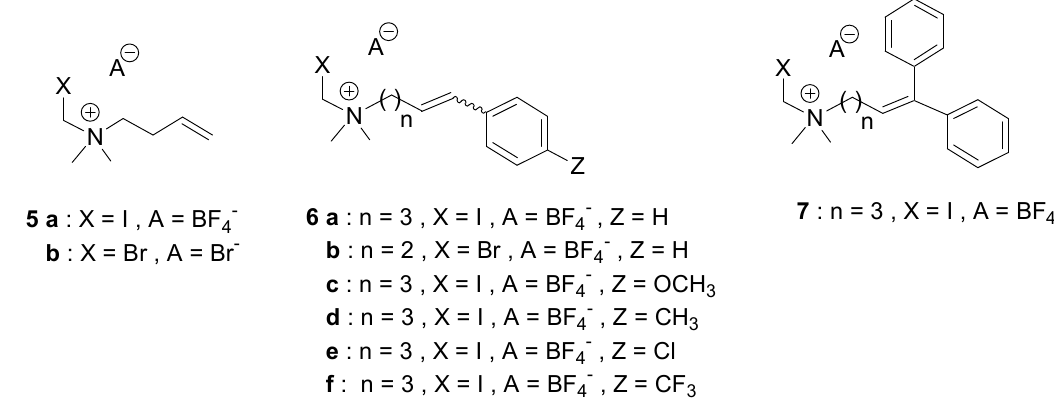
Figure 1. Compounds screened for in vitro efficacy against Leishmania tarentolae parasites.